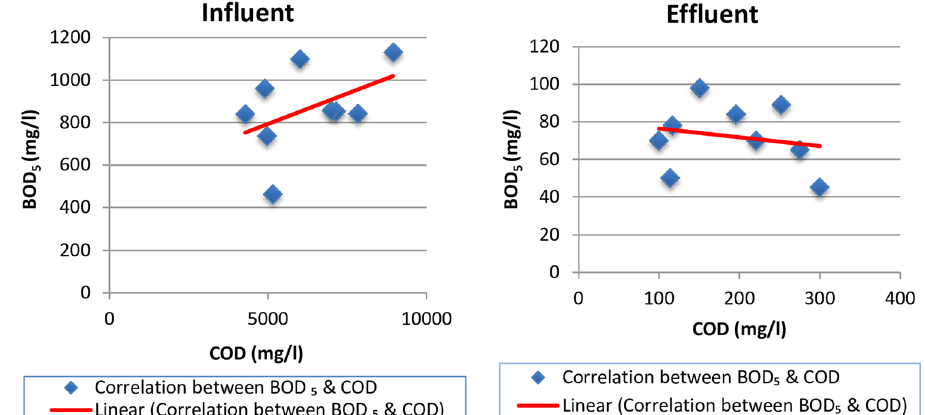
Fig. 3 Correlation between BOD 5 and COD in the influent and effluent of the pilot